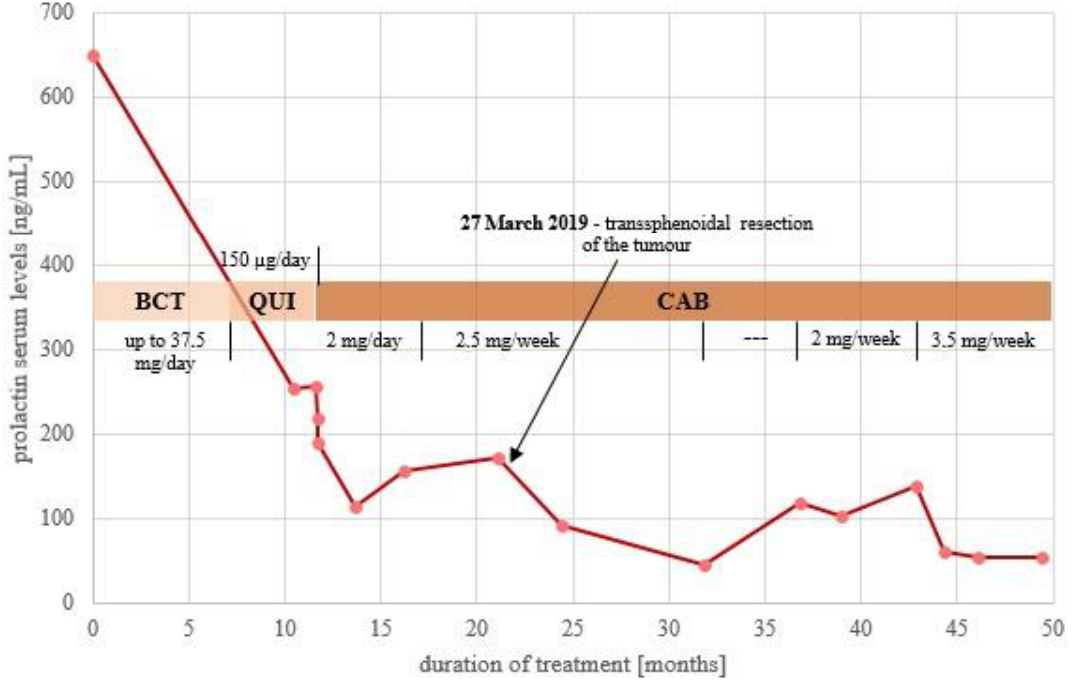
Figure 1. Variation in serum prolactin levels during a period of 4 years of dopamine agonists treatment (2017–2021). BCT—bromocriptine, QUI—quinagolide, CAB—cabergoline.